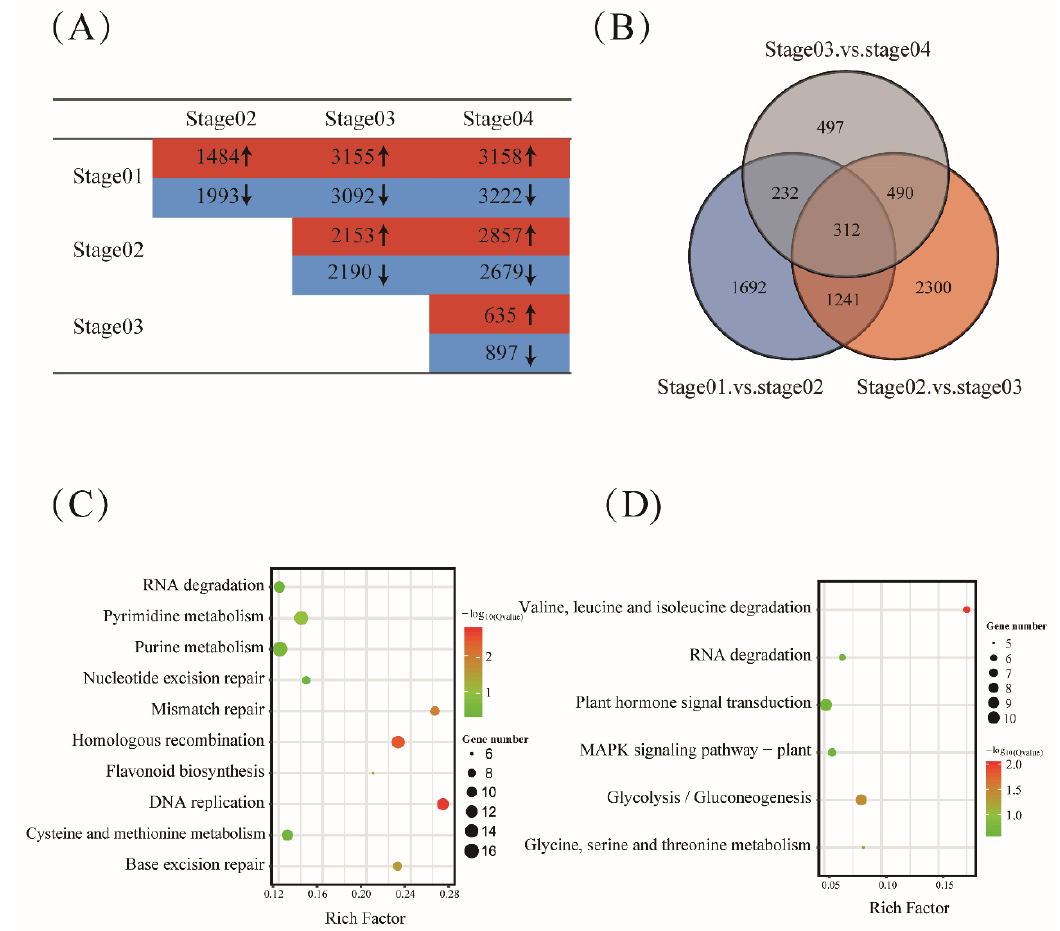
Figure 2. Differential expression genes during barley grain development. ( A ) Number of genes showing up- or downregulated expression during barley grain development (Padj < 0.05 and |log2Ratio| ≥ 1). ( B ) Venn diagram analyses of genes that were differentially expressed between any two consecutive stages in barley. ( C ) KEGG enrichment analysis of DEGs in cluster V during barley grain development. ( D ) KEGG enrichment analysis of DEGs in cluster VII.